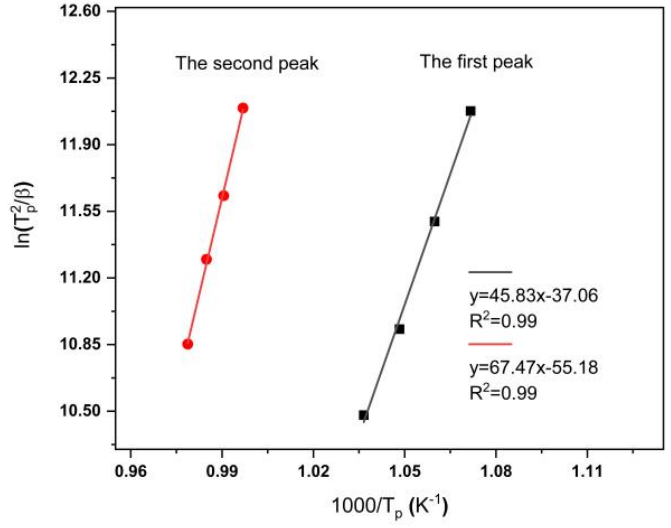
Figure 2. Schematic diagram of the relationship between ln( T p 2 / β ) and 1000/ T p for analysis of the first peak and the second peak.